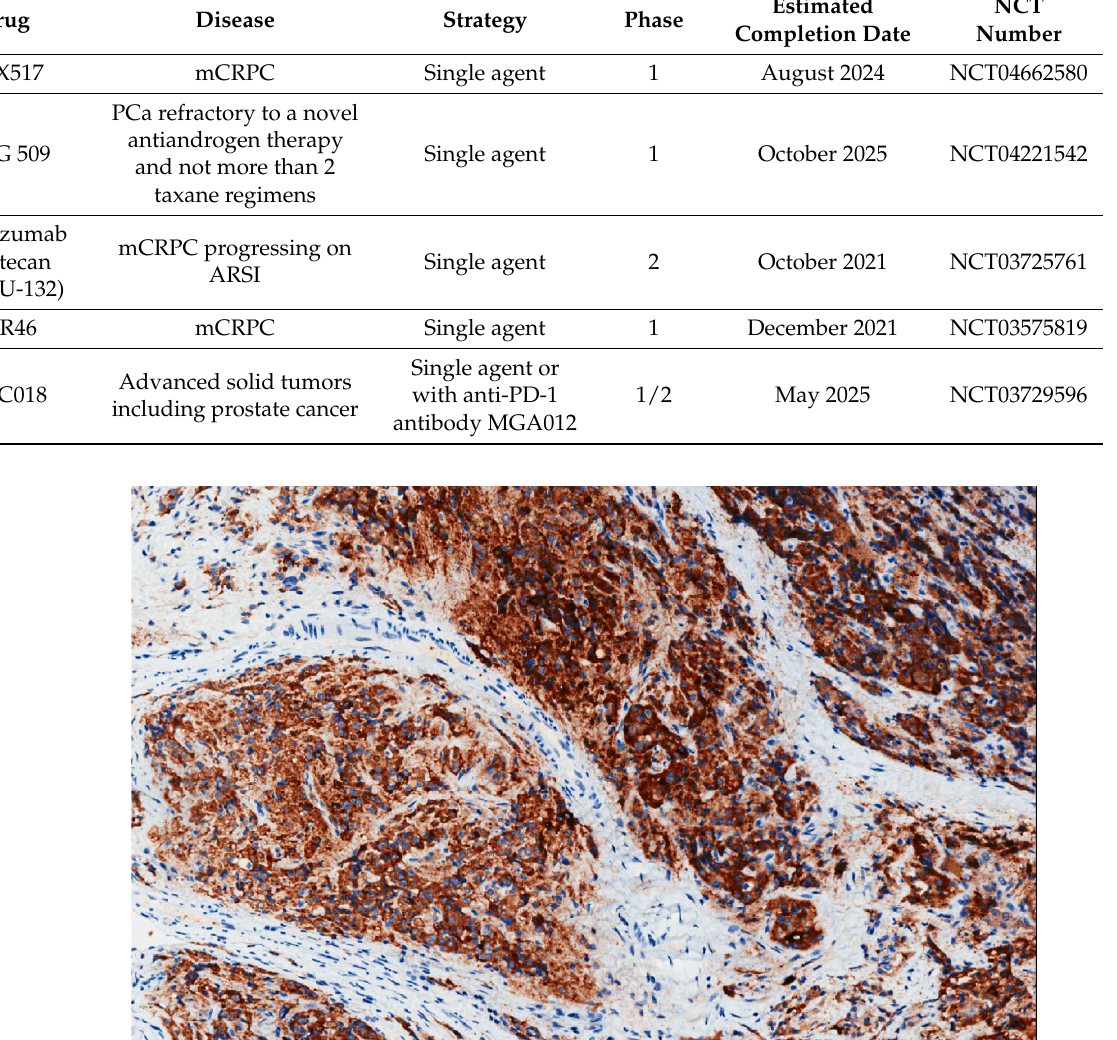
Figure 4. Immunohistochemical expression of PSMA in an androgen independence PCa (20 × Table 2. The clinical trial data of ADCs in PCa. ARSI = Androgen Receptor Signaling Inhibitor; mCRPC = metastatic Cas- tration-Resistant Prostate Cancer.